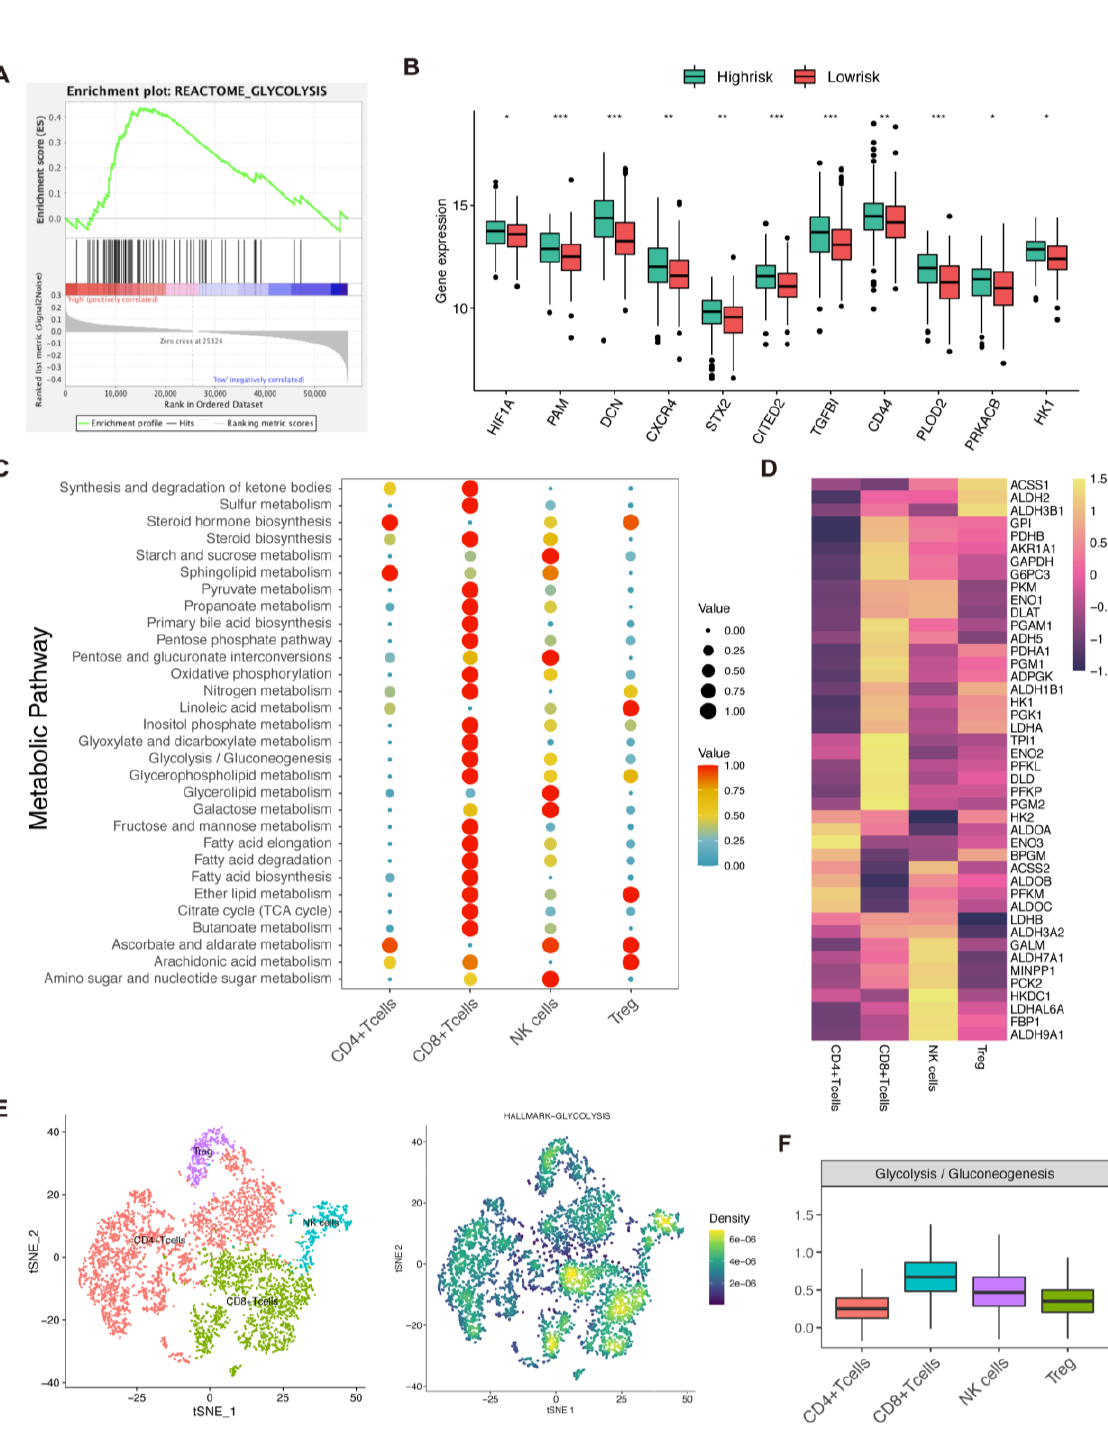
Figure 7. Metabolic status activity of gastric cancer patients. ( A ). GSEA analysis of metabolic-related gene sets. ( B ). Differential analysis of glycolysis-related genes between two risk groups (ns = non- significant; *, ** and *** = significant at 0.05, 0.01 and 0.001 levels, respectively). ( C , D ). The average metabolic gene expression and median metabolic pathway score of T and NK cells. ( E , F ). Single-cell glycolysis activity of T and NK